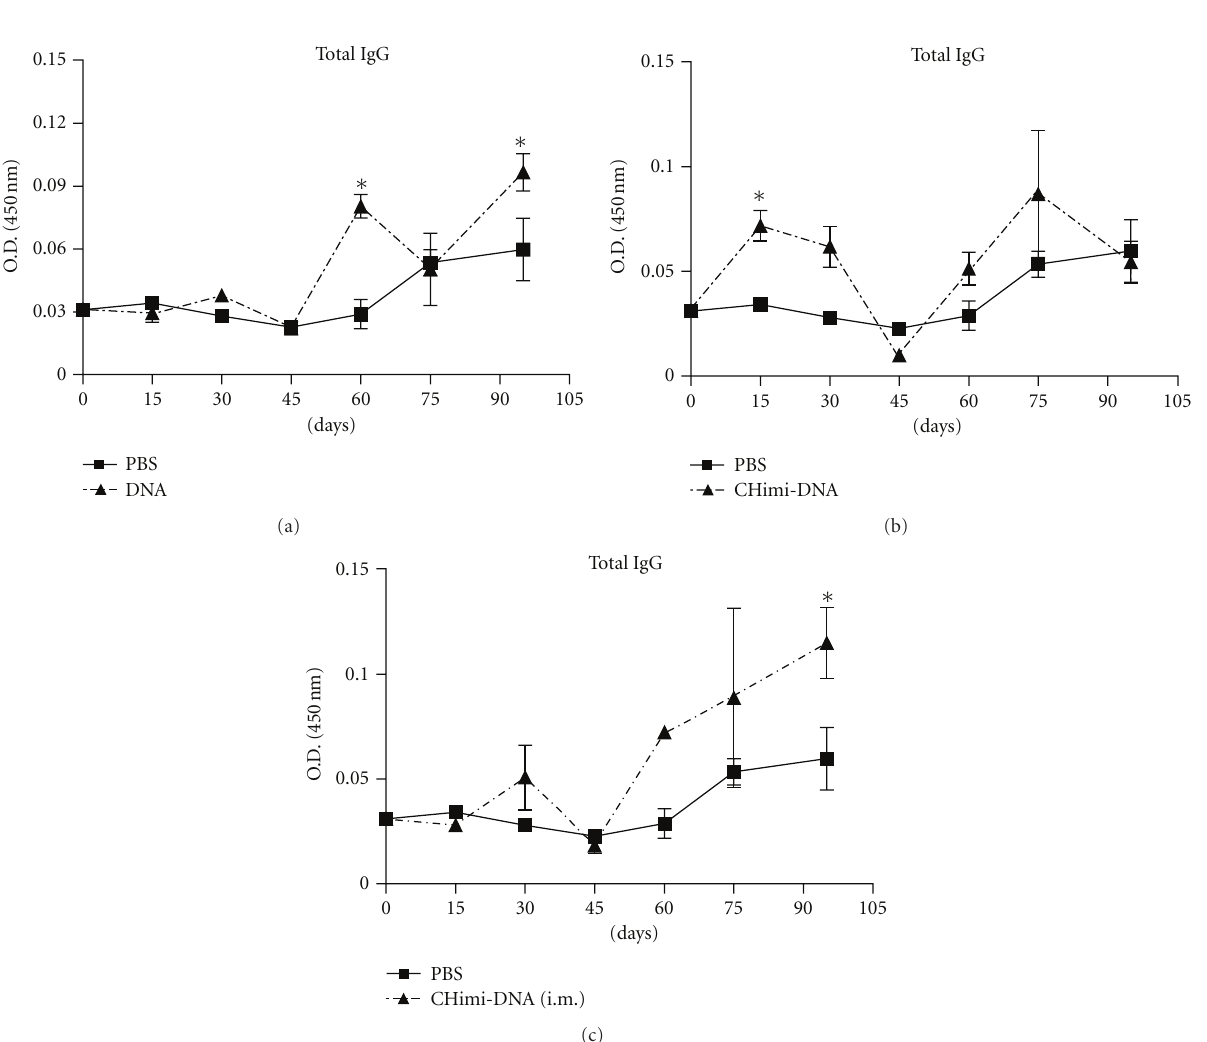
Figure 4: Serum anti-rSmRho-specific IgG levels of mice immunized orally with DNA (a) or CHimi-DNA (b) and intramusculary with CHimi-DNA nanoparticles (c). Sera of immunized mice were collected at days 15 (one week after the first immunization), 30, 45, 60, 75, and 95 and assayed by ELISA. The results are presented as the mean absorbance measured at 450nm for each group. Statistically significant di ff erences of vaccinated mice compared with the control group, PBS, in each time evaluated, are indicated by ( ∗ ) for P < 0 .